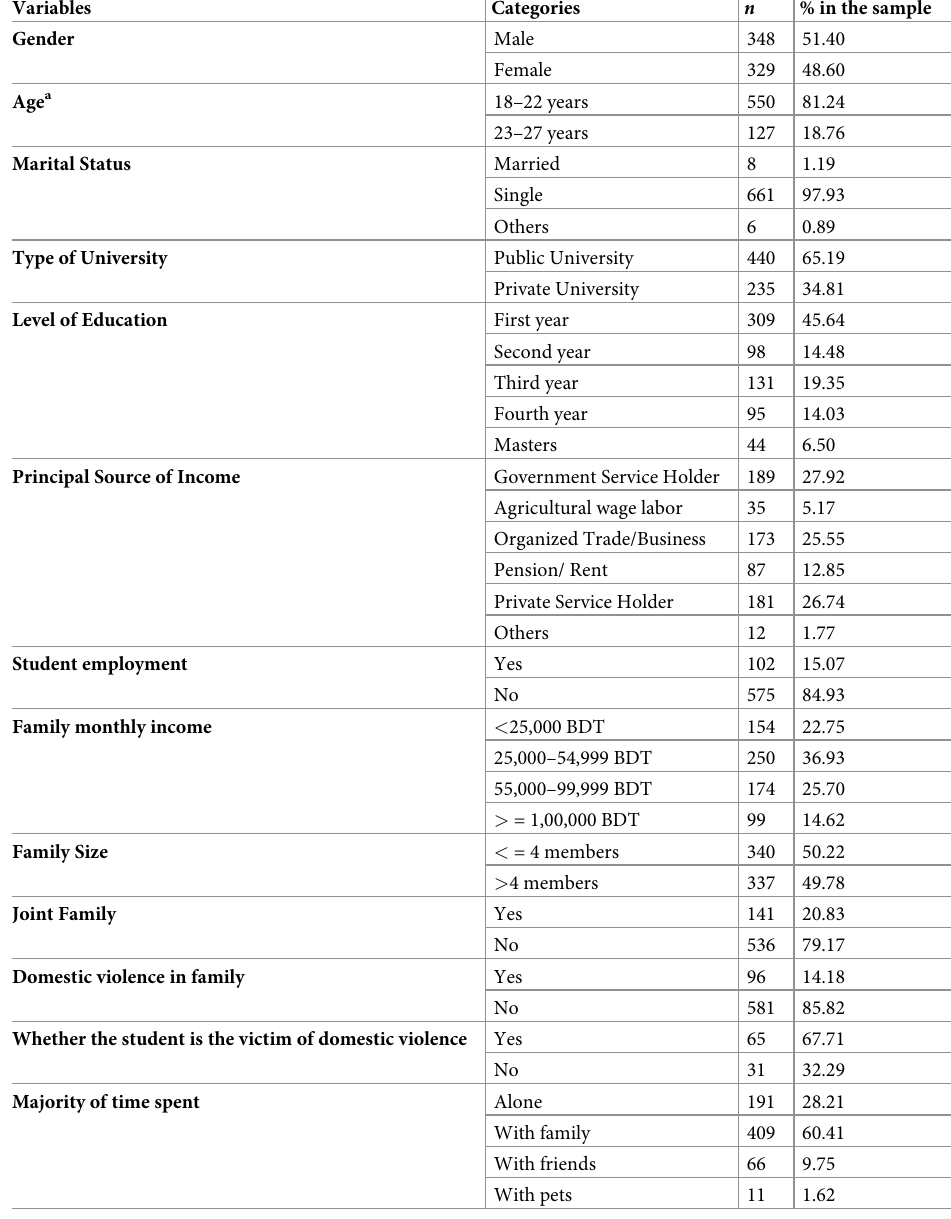
Table 1. Socio-demographic